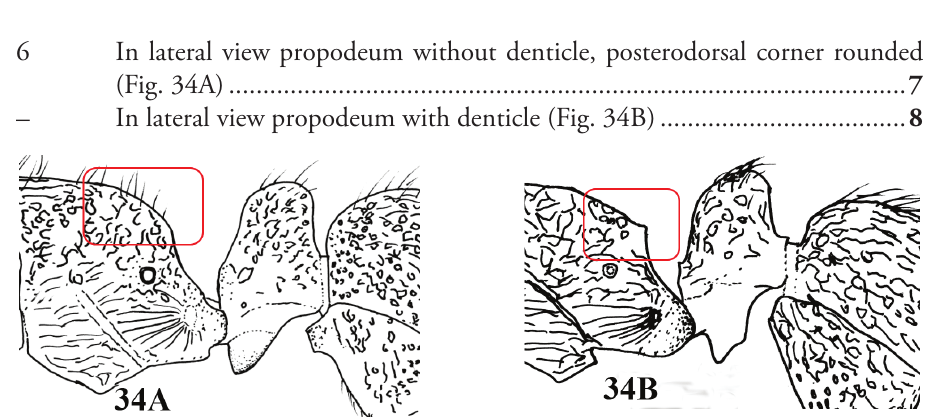
Figure 34. A G. nanlingensis worker B G. taivanensis worker. 7 In lateral view subpetiolar process triangular or cuneiform (35A); occipital lamella narrow and inconspicuous (Fig. 35C); fourth abdominalsternite is coarsely punctate ................. G. nanlingensis Chen, Lattke & Zhou, sp. n.